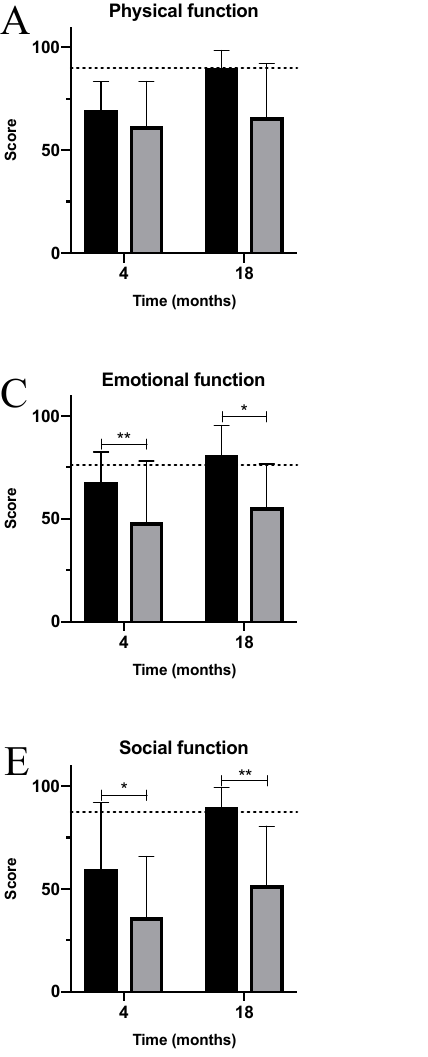
Figure 4. Function stratified by cohorts—RAMIE (black) vs. OTE (grey). ( A ) Physical function; ( B ) role function; ( C ) emotional function; ( D ) cognitive function; and ( E ) social function. OTE: open transthoracic esophagectomy; RAMIE: robot-assisted minimally-invasive esophagectomy.